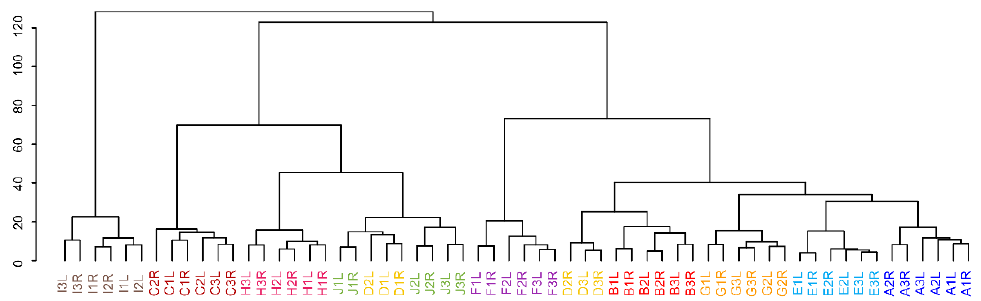
Figure 5. Hierarchical cluster analysis of lnPQN transformed data. Colors represent 10 individuals (A–J) who were sampled from the left (L) and right (R) sides for 3 different days (1–3).